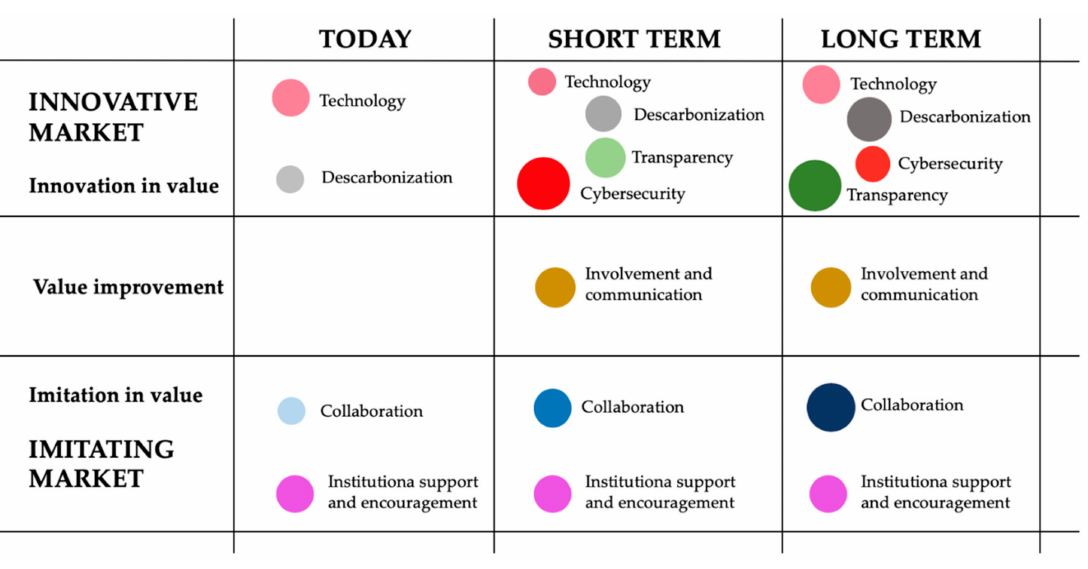
Figure 4. Map of perspective. Source: Own